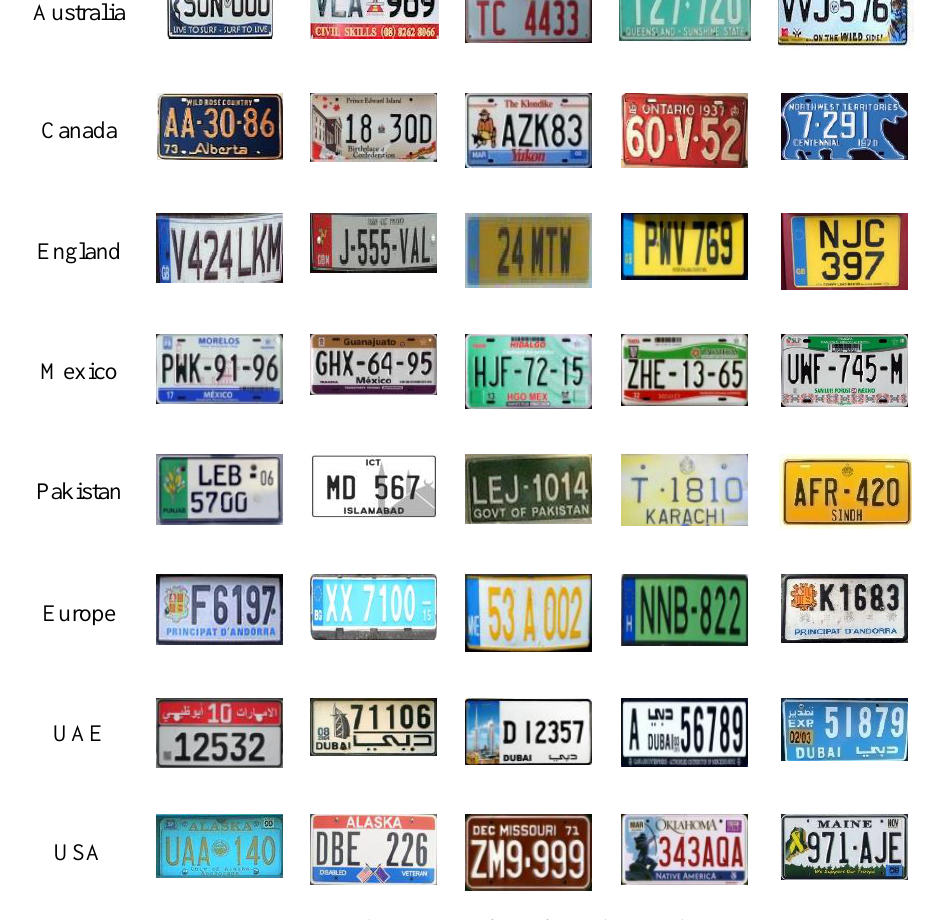
Figure 14. Samples images of LPs from the test dataset